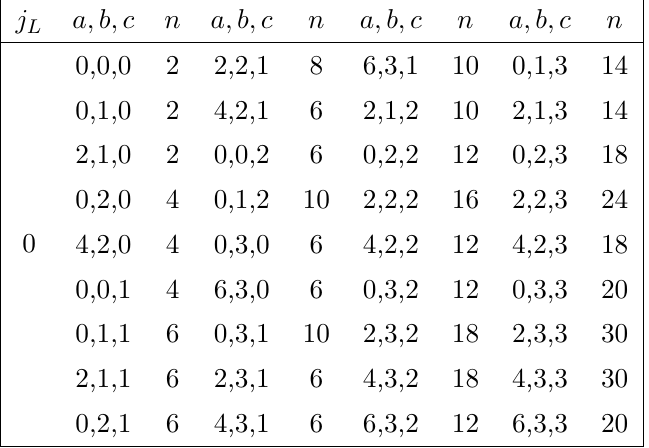
Table 2 . GV invariants n j L